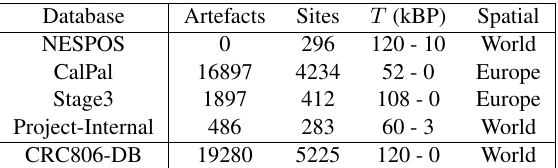
Table 1: Key numbers describing the integrated archaeological databases, T = temporal extent (oldest and youngest artefact) in kBP (kilo years before present) of database.